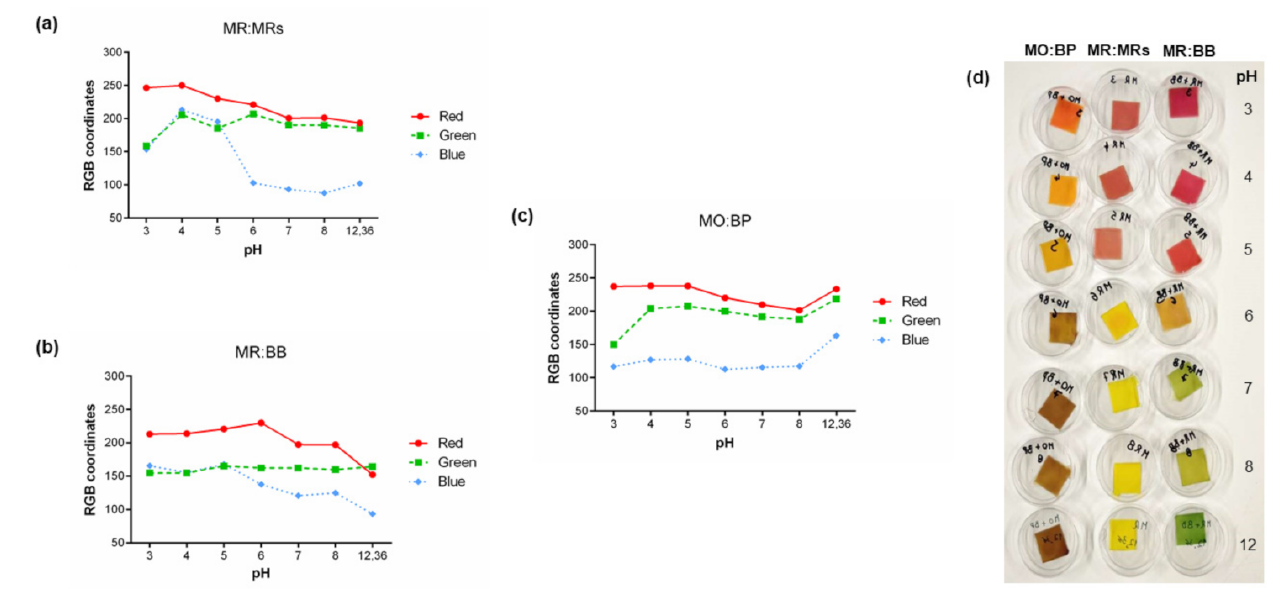
Figure 4. Graphical correlation of RGB color coordinates and the pH of filter paper samples func- tionalized with aqueous solutions of ( a ) MR:MRs, ( b ) MR:BB, and ( c ) MO:BP at a concentration of 0.5% ( w / v ), and ( d ) corresponding color